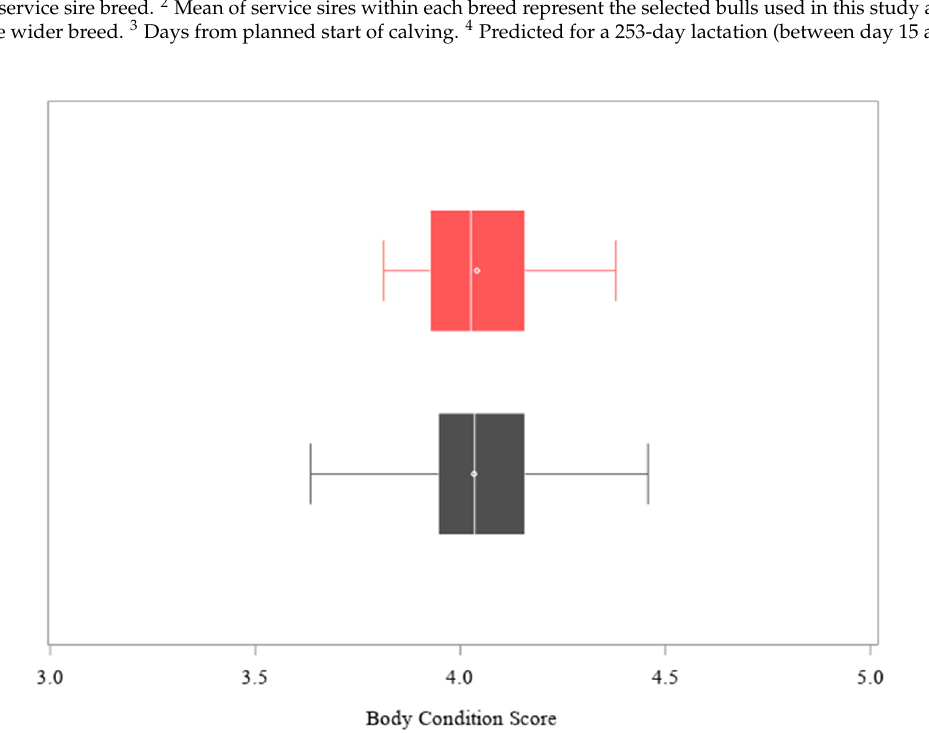
sire on the BCS of cows at rebreeding ( p = 0.045, Table 1; Figure 1), and the range among the least squares means for cows bred to different service sires was 0.82 condition scores (3.64 to 4.46). Table 1. Mean and standard deviation (SD) of the service sire mean and mean ( ± SD) of service sires within each breed for body condition score, post-calving live weight, milk production, rebreeding success, and survival traits. Trait